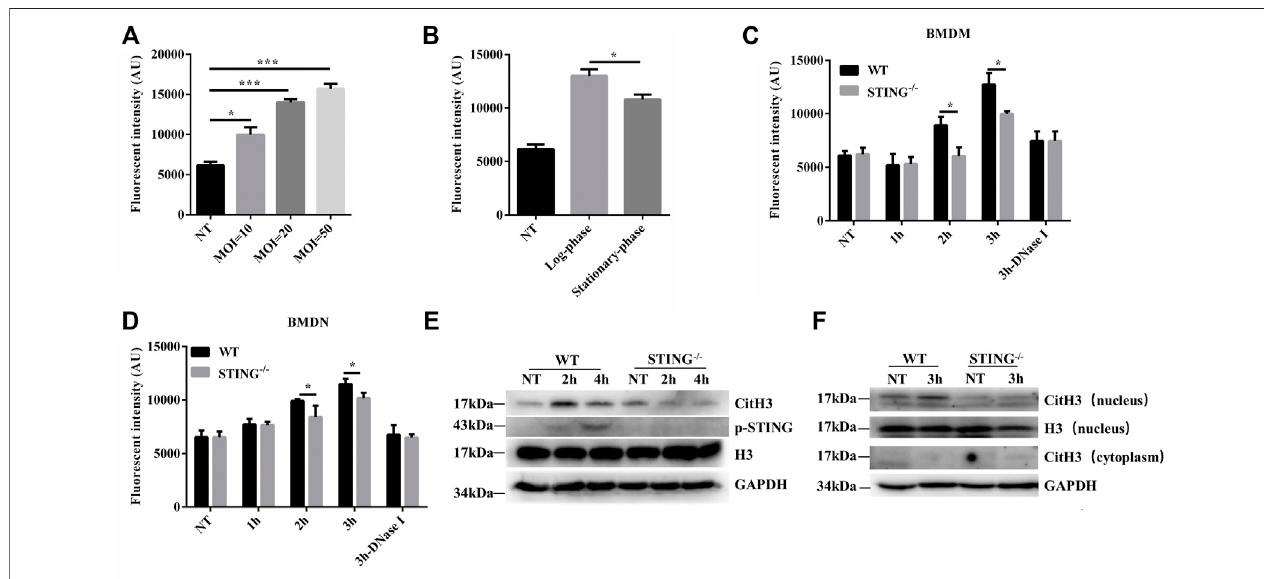
FIGURE 1| STING promotes ETs formation in macrophages and neutrophils after S. aureus infection. WT BMDMs were infected with S. aureus at designed MOIs anddifferentperiodsofgrowth. (A,B) ThecfDNAinsupernatantswasstainedwithSYTOXGreenandanalyzedona fl uorescentreader.BMDMsorBMDNsfromWTand STING -/- mice were infected with S. aureus (MOI: 20) at the designed time points. (C,D) Cells from WT and STING -/- mice were treated with DNase Ⅰ (100 U/mL) 20 min before infection with S. aureus . The cfDNA in supernatants was stained with SYTOX Green and analyzed on a fl uorescent reader. (E) Whole cell lysates and (F) nuclear proteins were analyzed for CitH3, H3, p-STING, and GAPDH by Western blotting. Data are shown as mean ± SEM. Data were pooled from 3 independent experiments. Data were analyzed using two-way ANOVA with Bonferroni ’ s multiple comparison test. For all experiments in this fi gure: * p < 0.05.